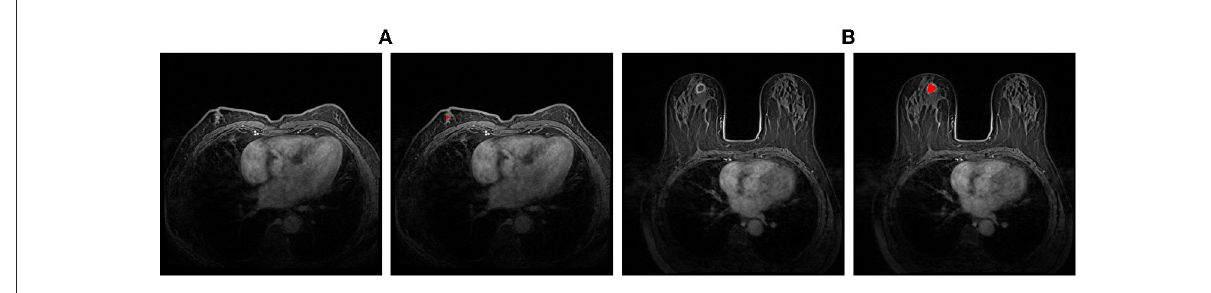
FIGURE1 Examples of hard samples. (A) An example with inapparent tumor; (B) An example with the tumor necrosis. The left one of each pair is the original image, and the right one is the segmentation